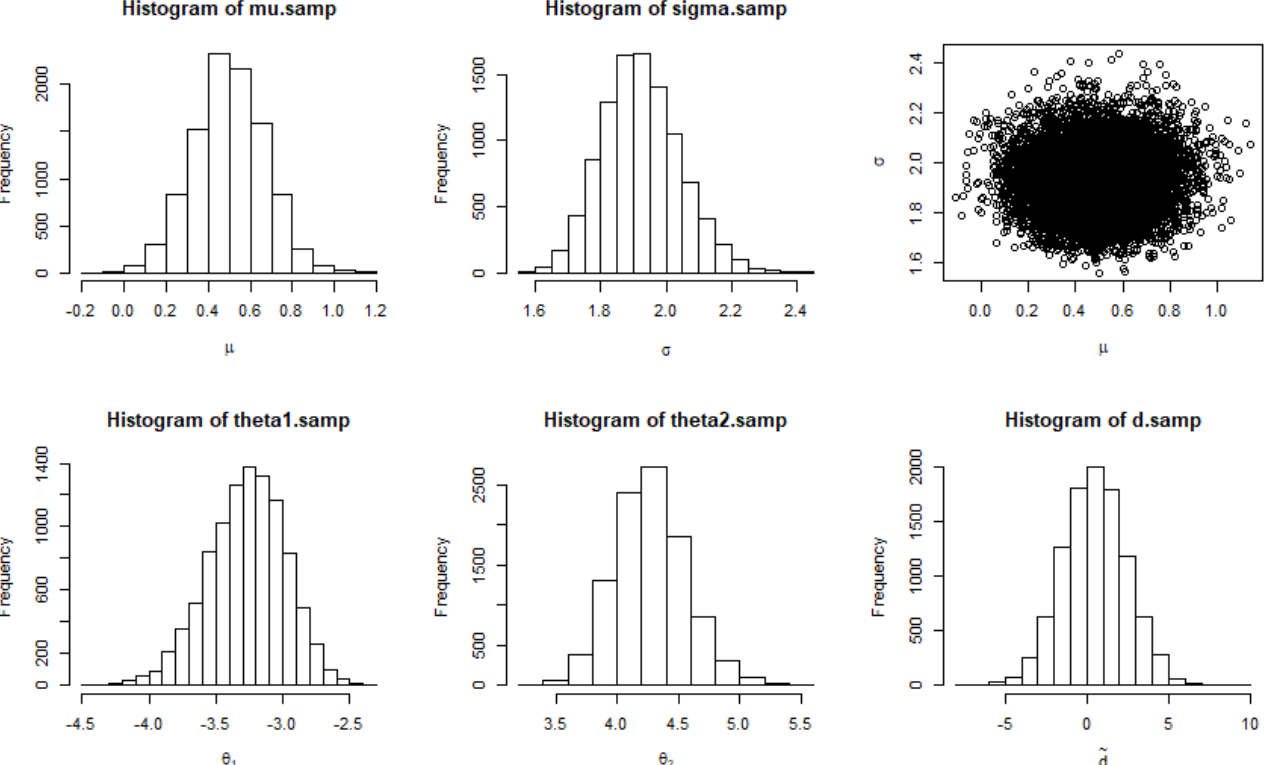
1084 Figure 2. Classical Bland–Altman plot including the estimated LoA and a regression line of the differences on the means, extended by a prediction interval for a future difference (short dashes)